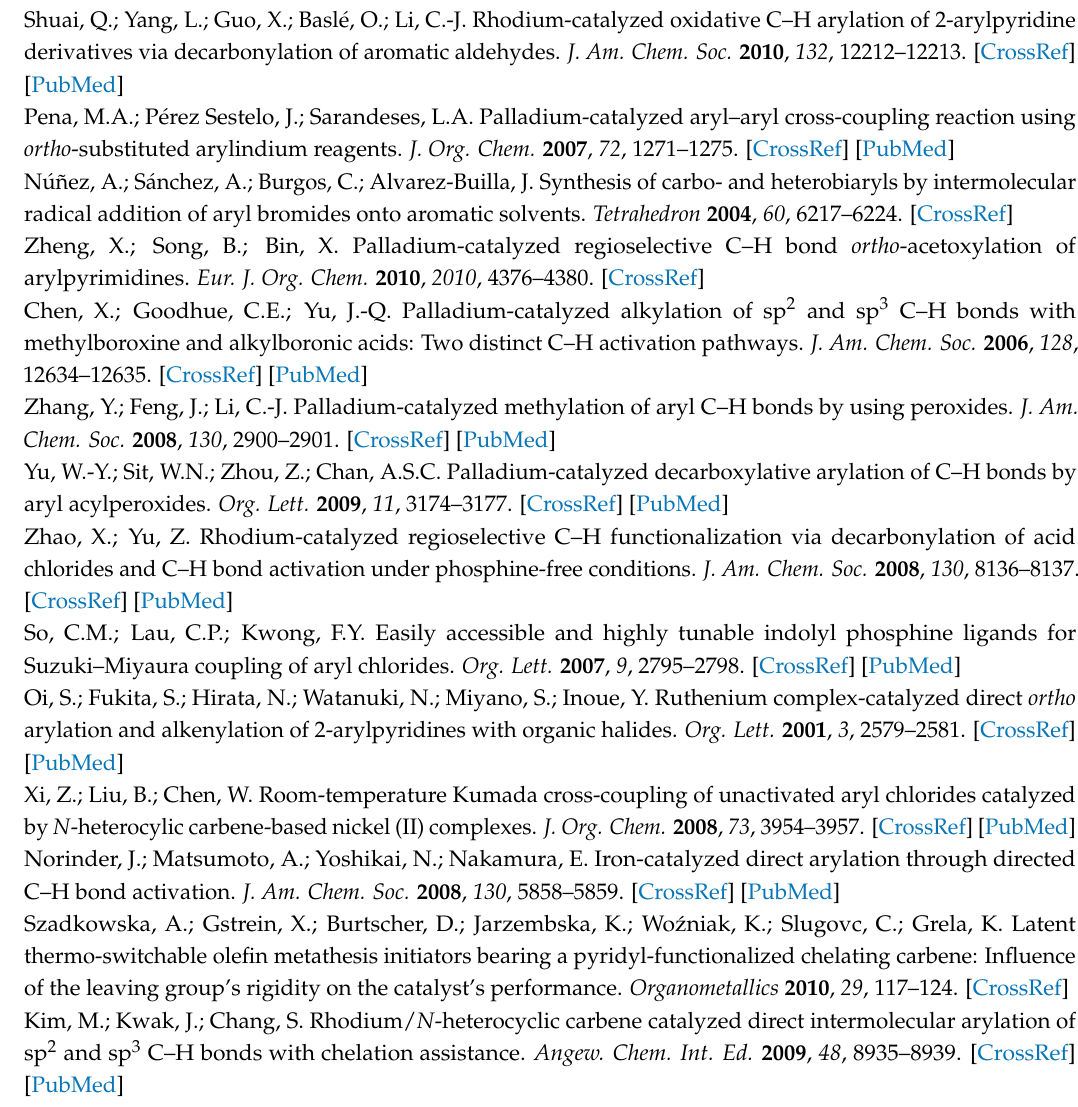
Sample Availability: Samples of the compounds 2a , 2b , 7a , 7b , 8a , 8b , 9a , 9b , 10a , 10b are available from the